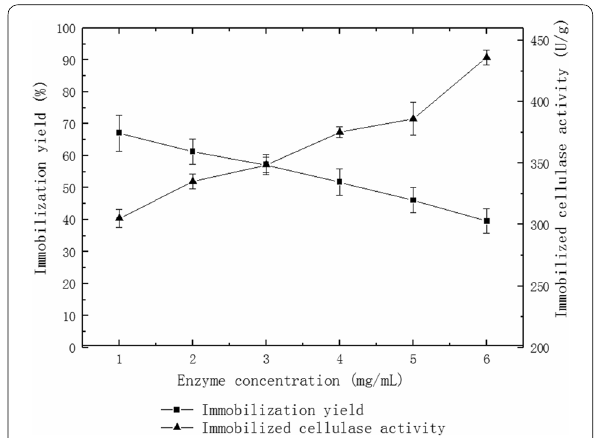
Fig. 2 Effects of enzyme concentration on immobilized cellulase activity and immobilization yield Fig. 3 Effect of temperature on cellulase activity